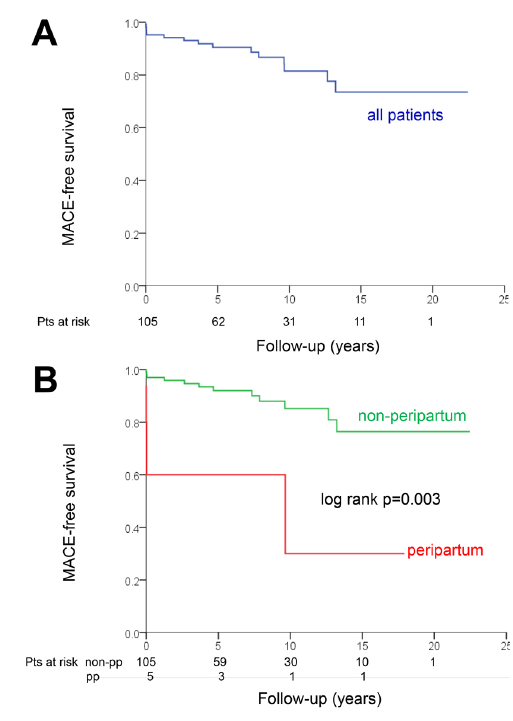
Figure 6: Kaplan Meier plots showing survival free of major car- diovascular events (MACE) in the entire cohort (panel A) and in peripartum versus non-peripartum cases (panel